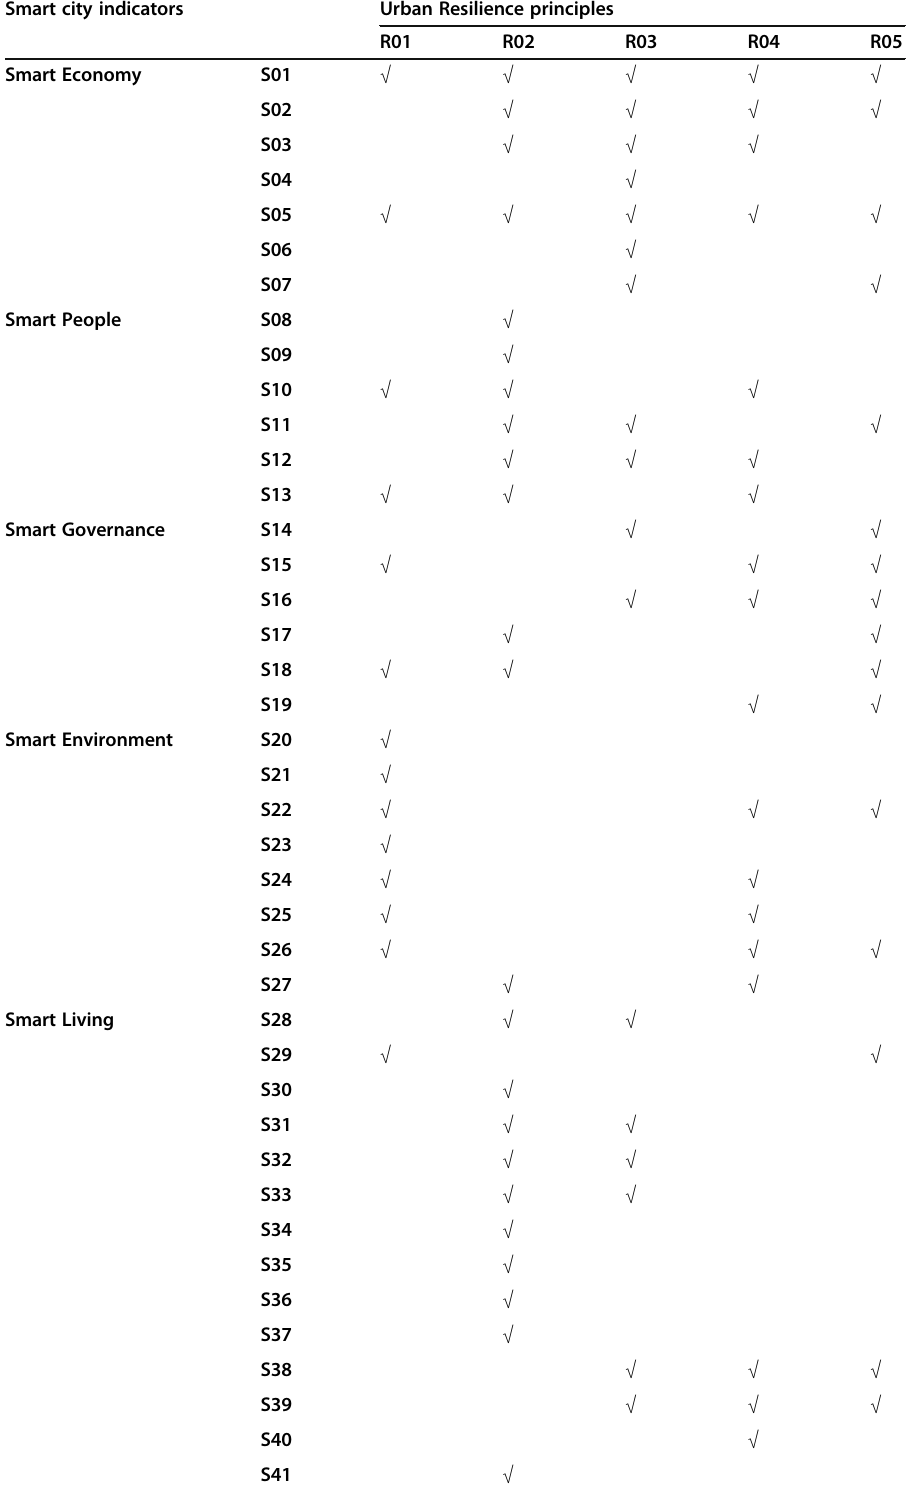
Table 6 Mapping relationship between smart cities indicators and principles of urban resilience (Authors) Smart city